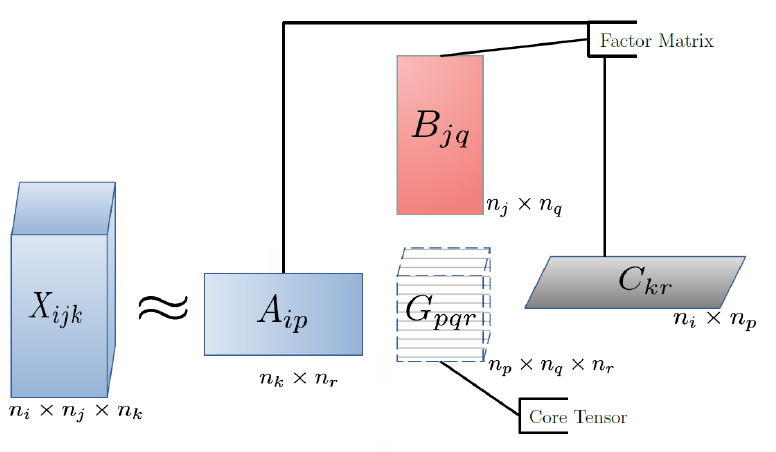
Figure 6. Dimensionality reduction in the factorized